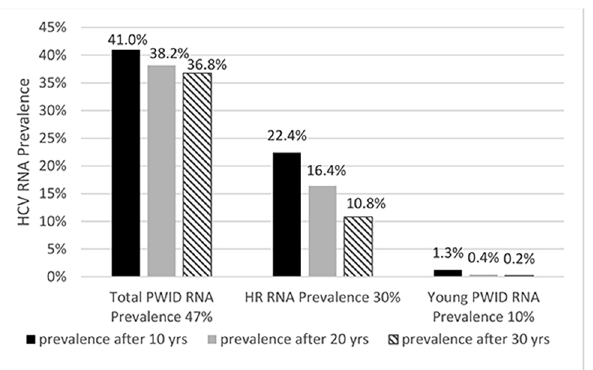
Fig 4. Resulting H RNA P after 10, 20 and 30 years of treating 10 infections per 1000 PWID with 90% SVR rate, 12-week treatment duration and acquired immunity ( ξ = 0.8). Predicted effect from Chicago ’ s overall baseline H RNA P (47%), Chicago ’ s harm reduction (HR) attending PWID (30%) and Chicago ’ s subpopulation with low baseline H RNA P